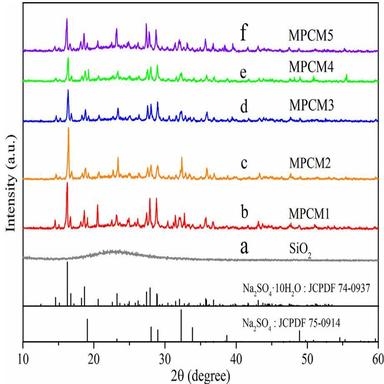
XRD patterns for (a) silica and (b–f) MPCM1–MPCM5.